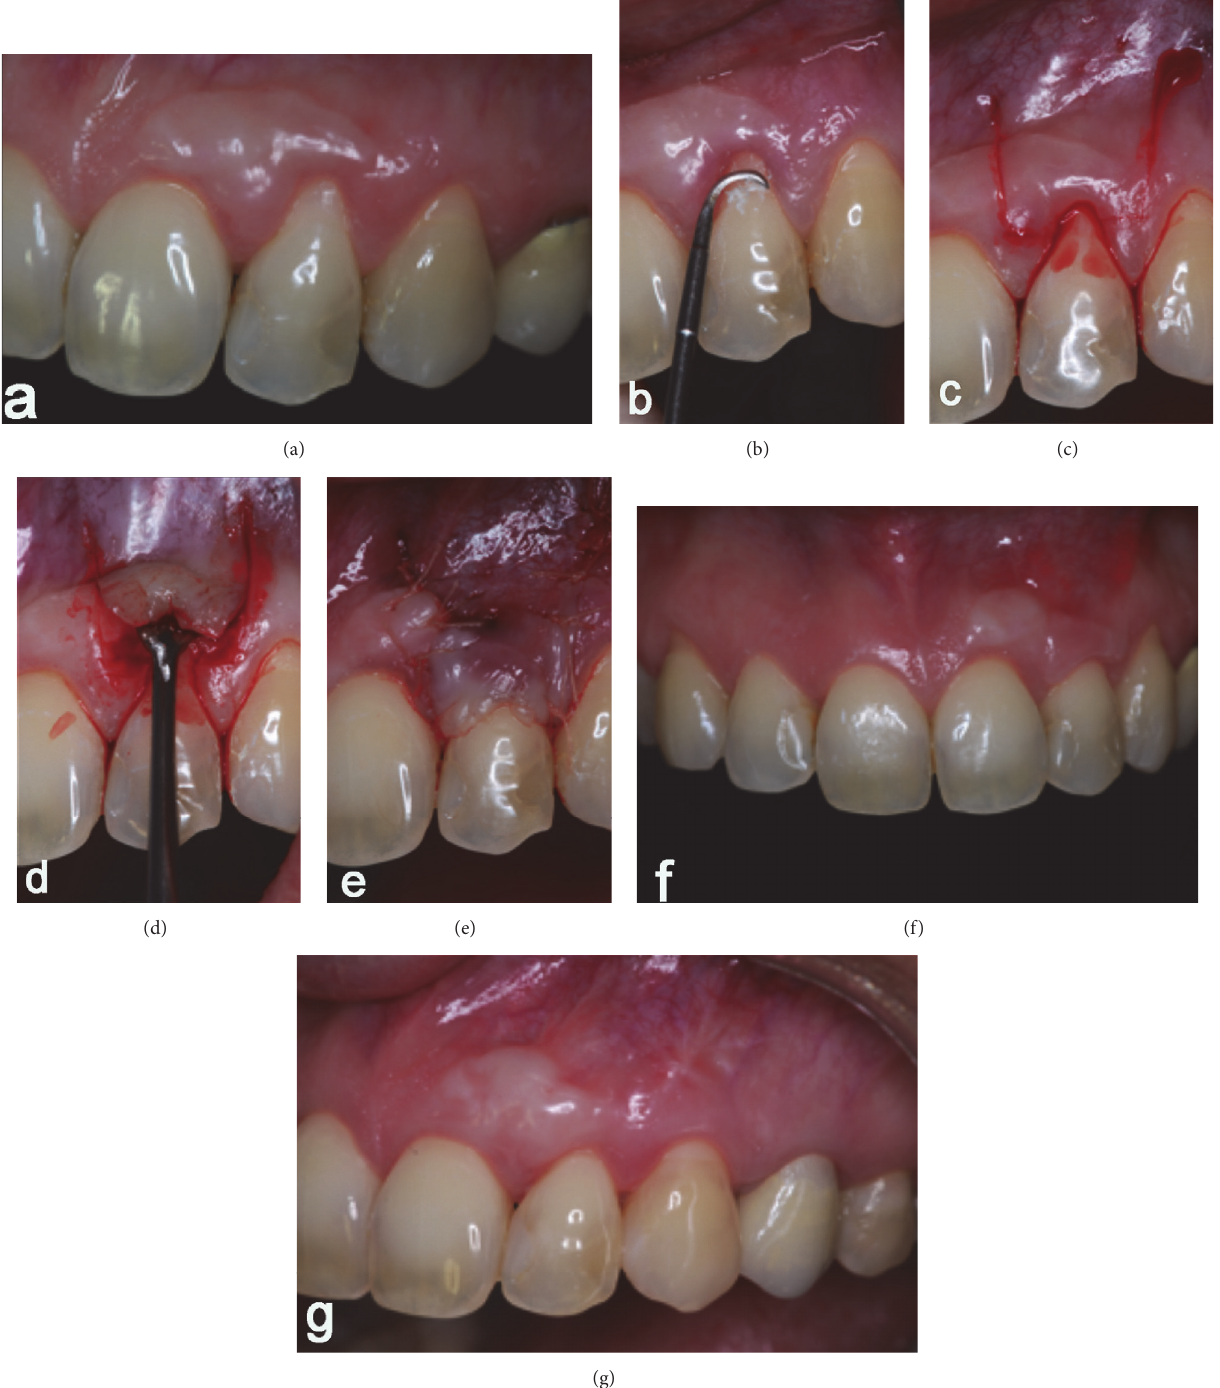
Figure 2: (a) After three months of the procedure; ((b), (c), (d), and (e)) a second surgical stage was performed in order to cover the exposed root of tooth 22; (f) root coverage of 100% after 6 months and (g) 5-year